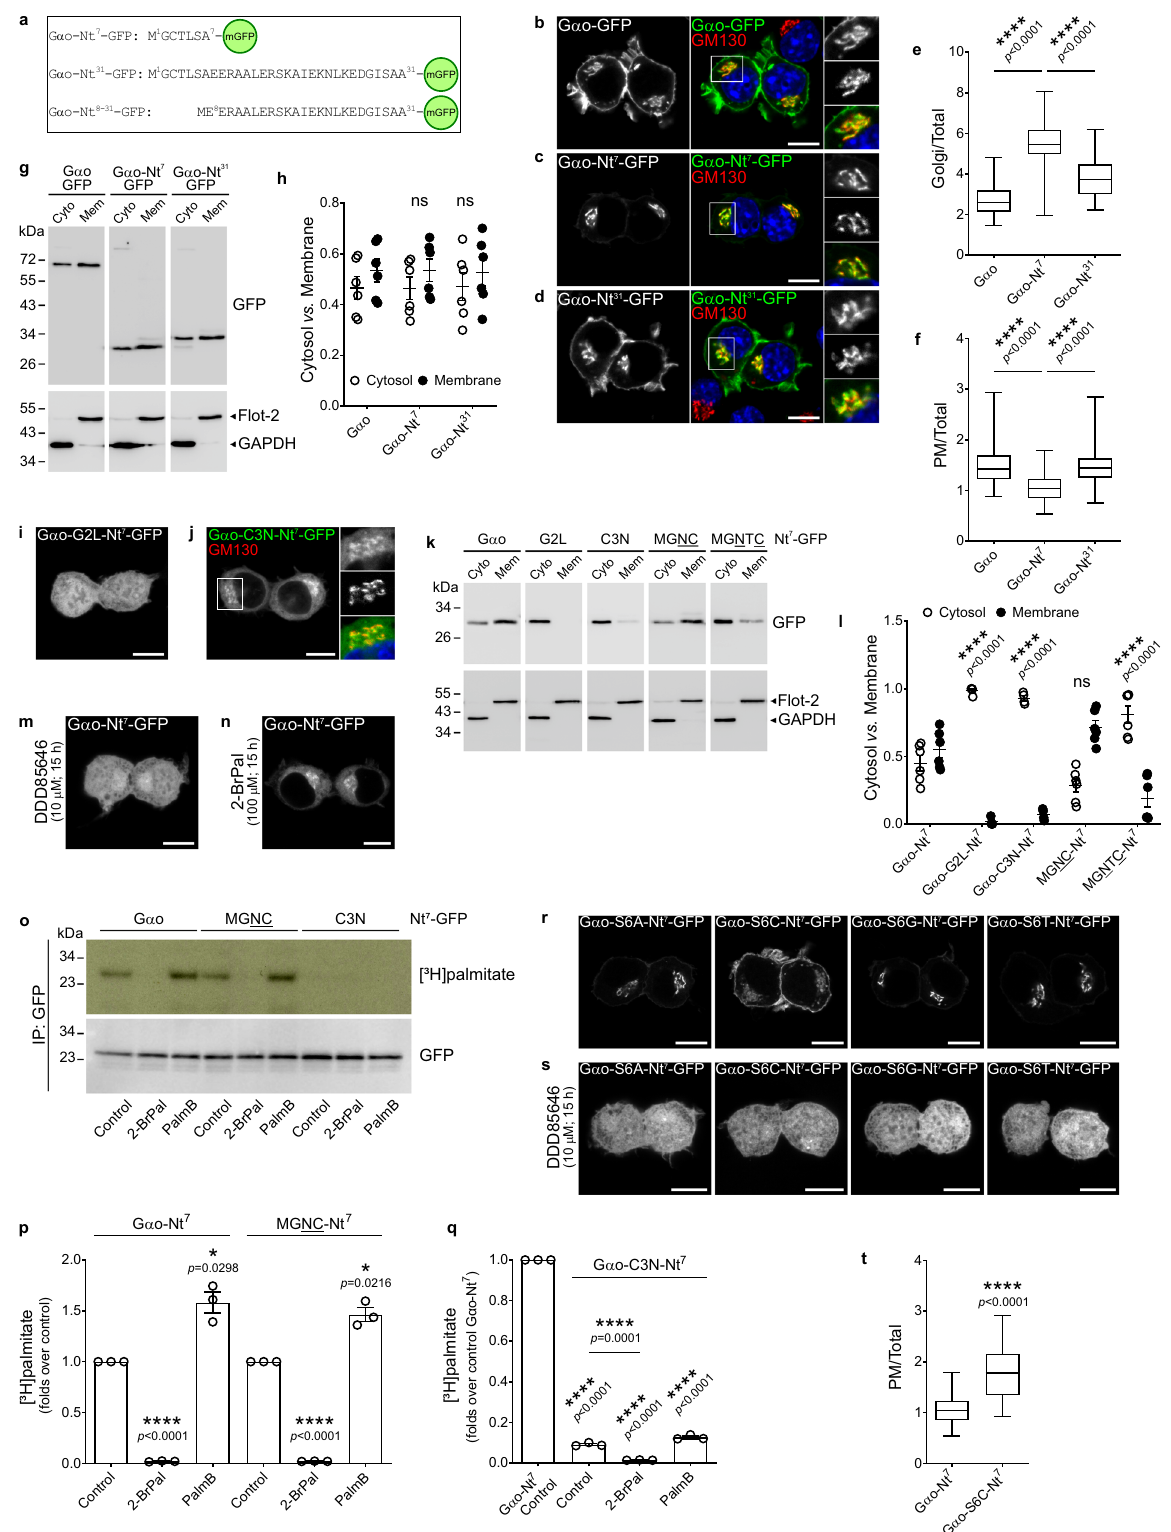
Key residues in G α o-Nt 7 . We next aimed to decode the rules of intracellular localization of G α o-Nt 7 by a systematical point mutation analysis of its residues. Amino acid substitutions were designed using the GPS-Lipid prediction tool 21 . For instance, we introduced the Gly-to-Leu mutation at position 2 of G α o-Nt 7 - GFP as GPS-Lipid predicted very high likelihood for NATURE COMMUNICATIONS| (2022) 13:2072